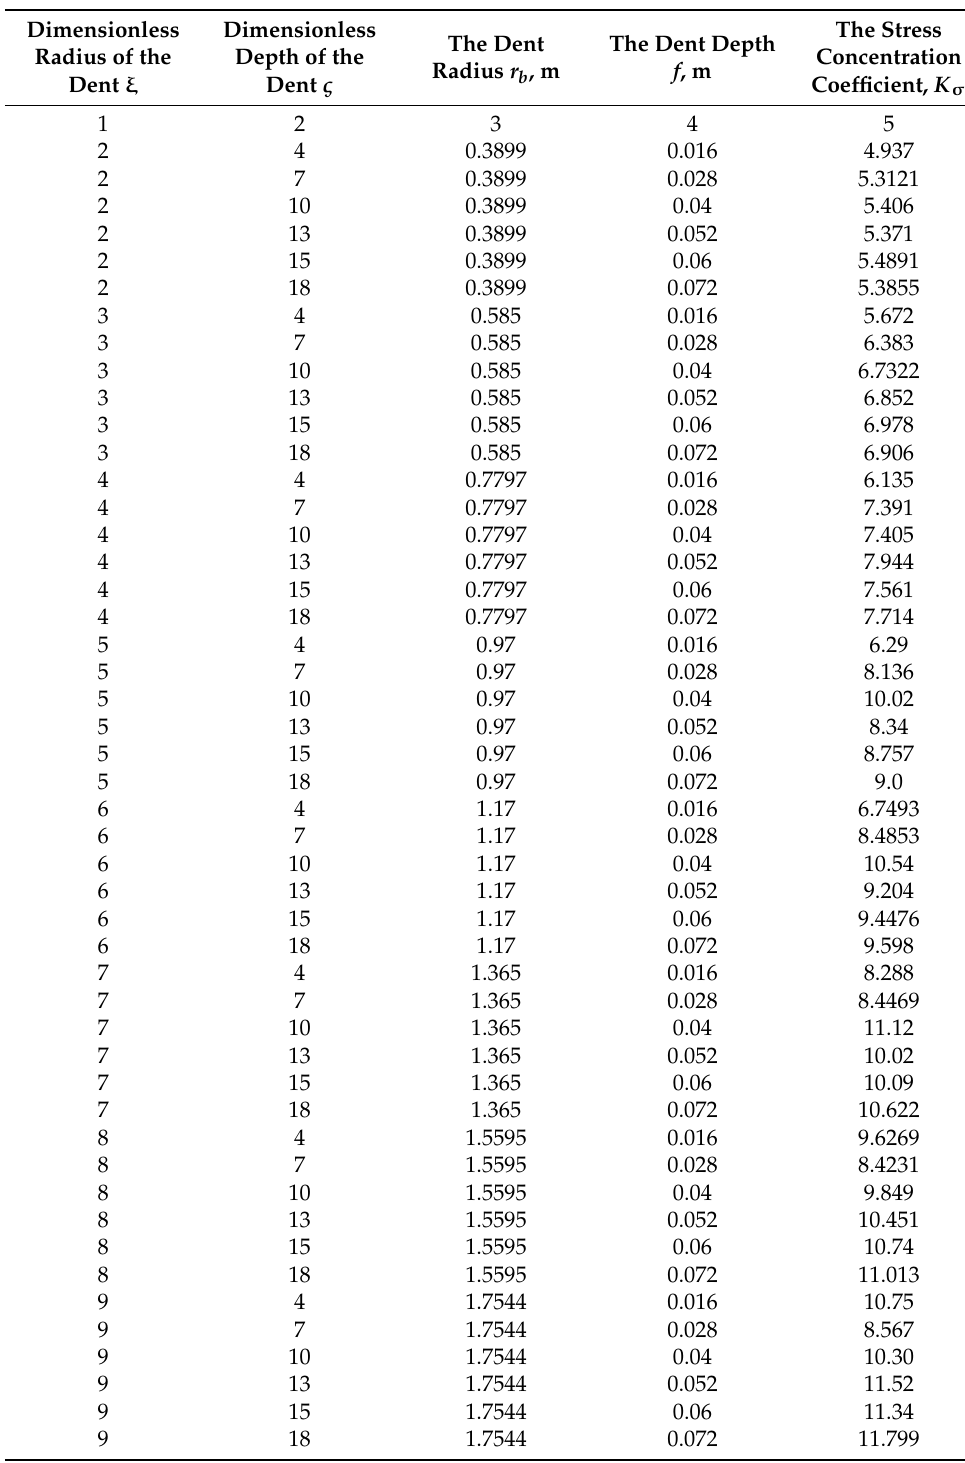
Table 5. The results of calculating the stress concentration factor, K σ , in the dent zone in the cylindrical tank wall.